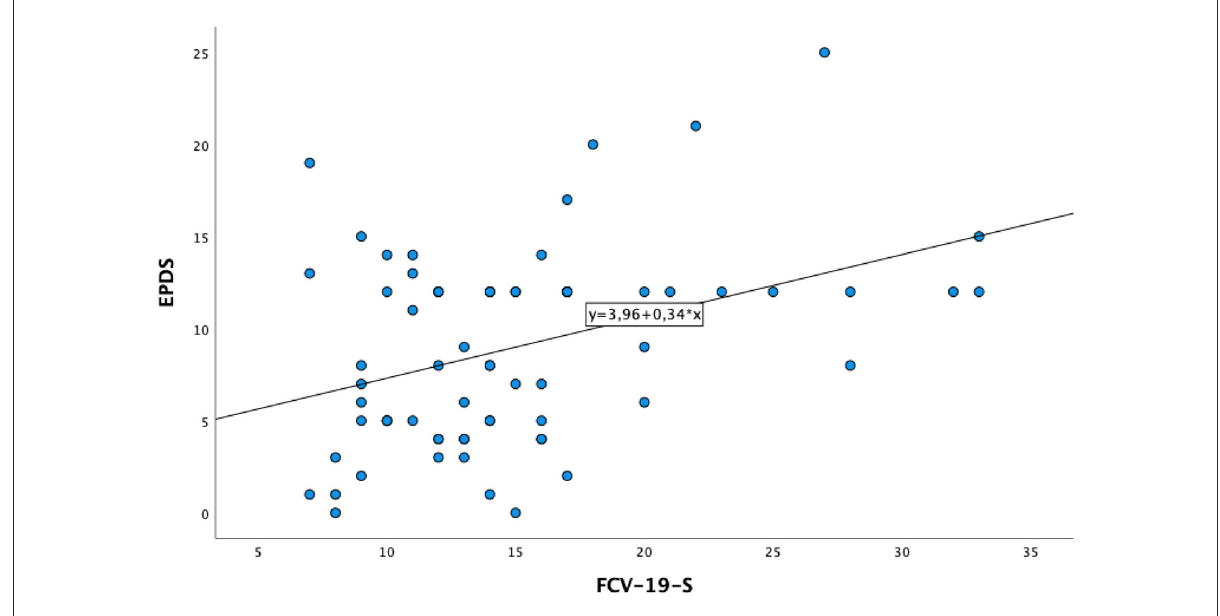
FIGURE1 Linear regression model between FCV-19-S and EPDS.